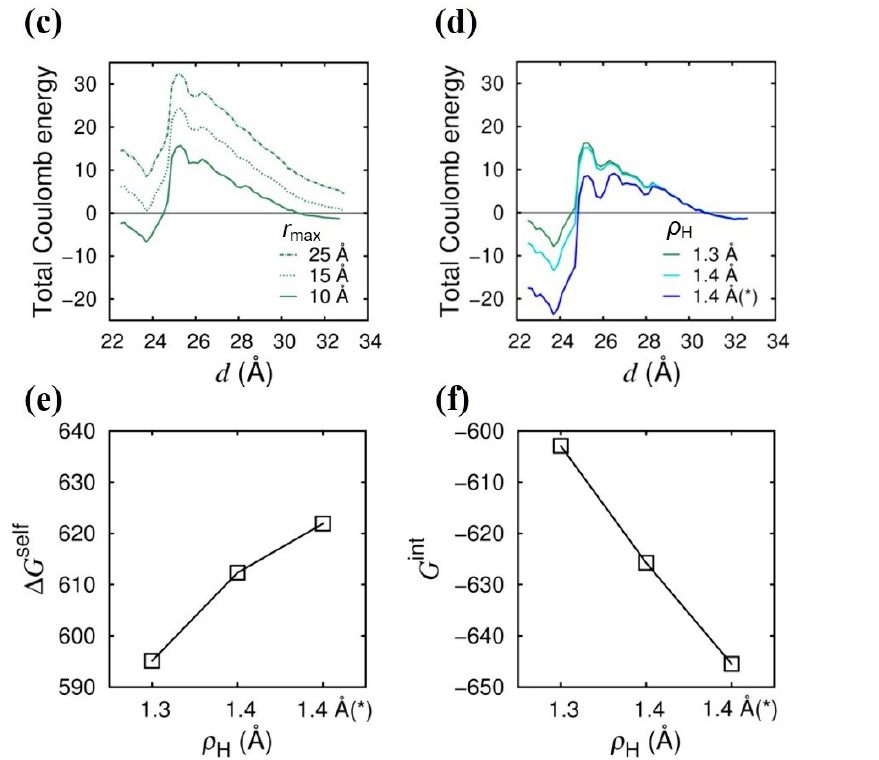
Figure 3. Effect of r max and ρ H on Coulomb energies in Bn–Bs system. ( a ) Illustration of the system. Coulomb potential at the surface of Bn and Bs is shown by the color map [red: − 10 kT / e ; blue + 10 kT / e , where e is the elementary charge, k is the Boltzmann constant, and T is temperature (300 K)]. Binding interfaces of Bn and Bs (rotated by 90 ◦ ) are displayed beneath. Coulomb potential was calculated by APBS [34]. ( b ) Potential of mean force (PMF) is shown as a function of the intermolecular distance d [see ( a )] obtained by conducting an umbrella sampling with the explicit water. ( c ) Total Coulomb energy is shown as a function of d at different r max values ( r max = 25, 15, and 10 Å). ( d ) Total Coulomb energy is shown as a function of d at different ρ H values ( ρ H = 1.3 and 1.4 Å). The asterisk (*) indicates that the intrinsic radius of the carboxyl oxygen ( ρ O ) in the side chain of acidic residues is also changed (from 1.5 to 1.6 Å). ( e ) Total desolvation energy ( ∆ G self ) and ( f ) total interaction energy ( G int ), averaged in the range of 23.6 ≤ d ≤ 23.8 Å, are shown as a function of ρ H . Energy unit is